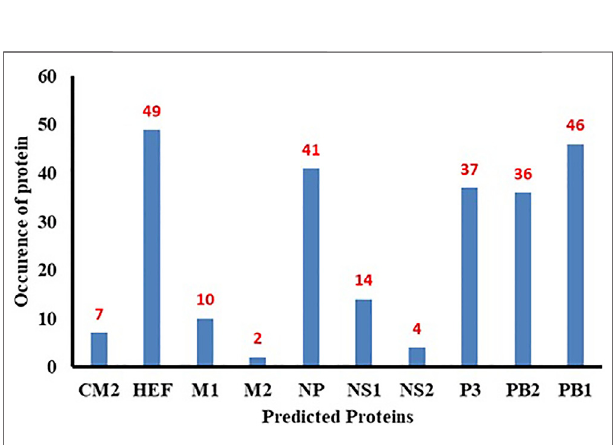
FIGURE 10 | Bar chart of predicted